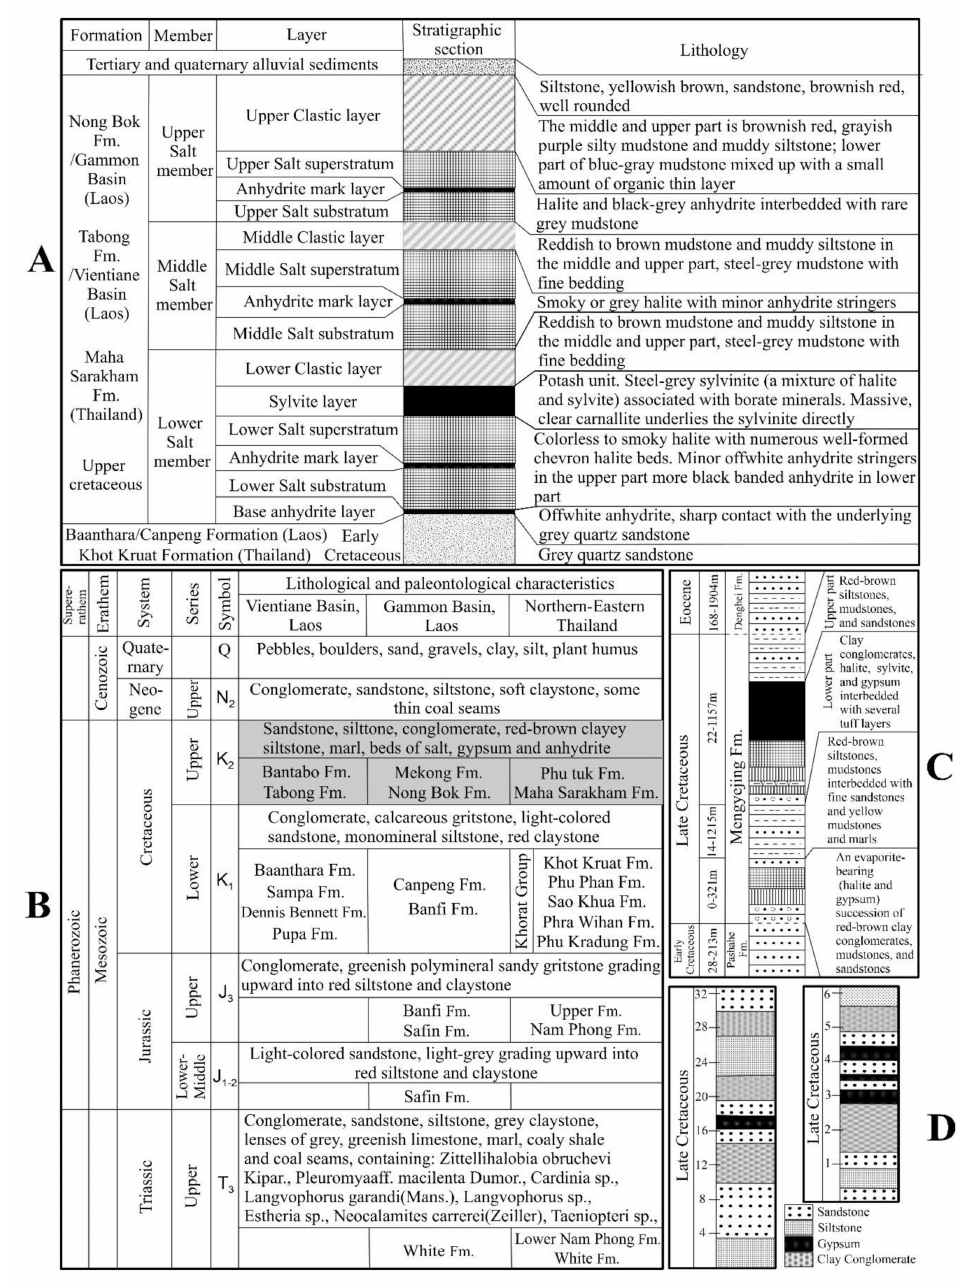
Figure 2. ( A ). Lithostratigraphy of the saliferous strata in the Laos and northeast Thailand [65]; ( B ). Phanerozoic stratigraphic correlation of Northeast Thailand–Vientiane Basin–Gammon Basin of Laos; ( C ). Lithostratigraphic column of the Mengyejing Formation in the Simao basin, southwestern China (modified from Wang et al., 2014); ( D ). Lithostratigraphic column of the Late Cretaceous section in the Muong Say Basin